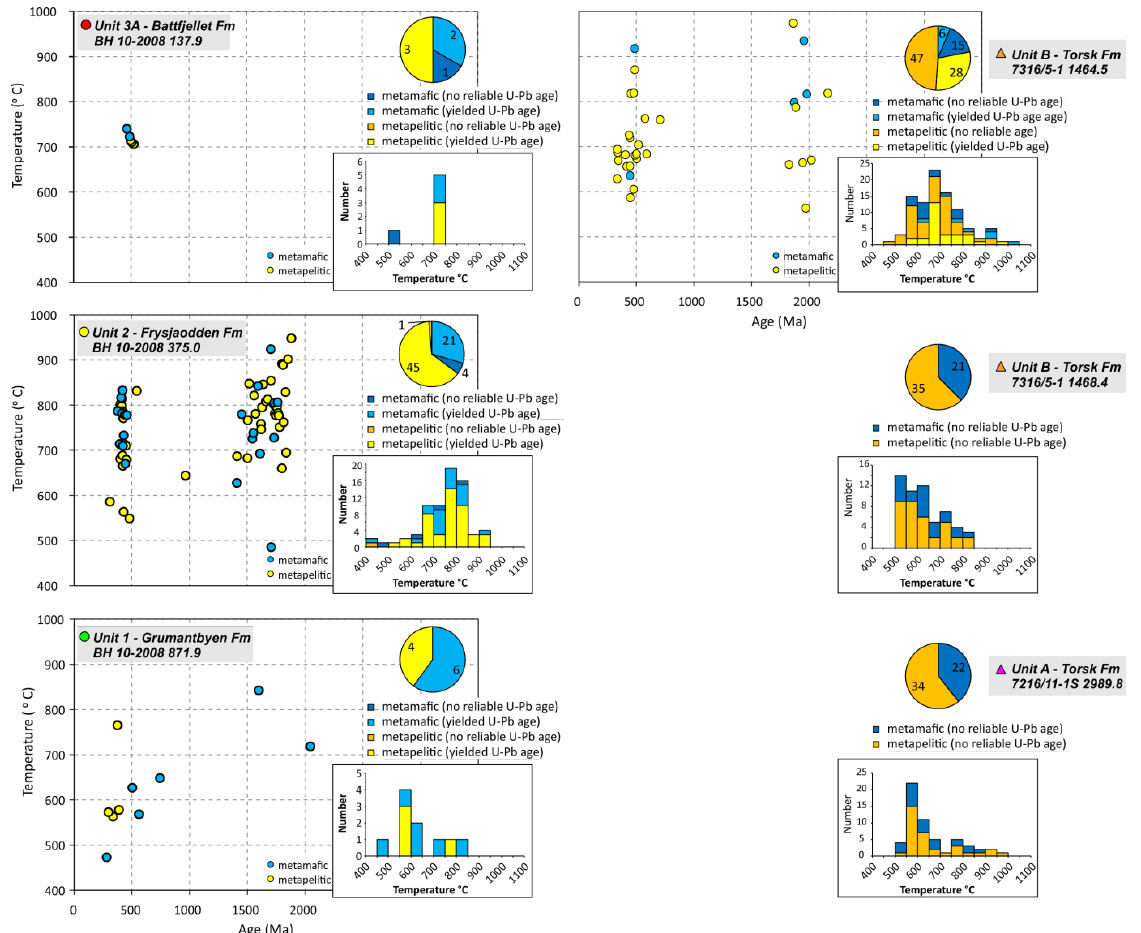
Figure 9. Rutile trace elemental data showing histograms of crystallisation temperature using the Zr in rutile geothermometer of Watson, Wark and Thomas [78] and pie charts of protolith type after Meinhold [77]. The number in the pie chart indicates the number of analyses. The cross plots show the temperature and protolith-type against the calculated U-Pb age for the analyses where reliable U-Pb ages were determined.